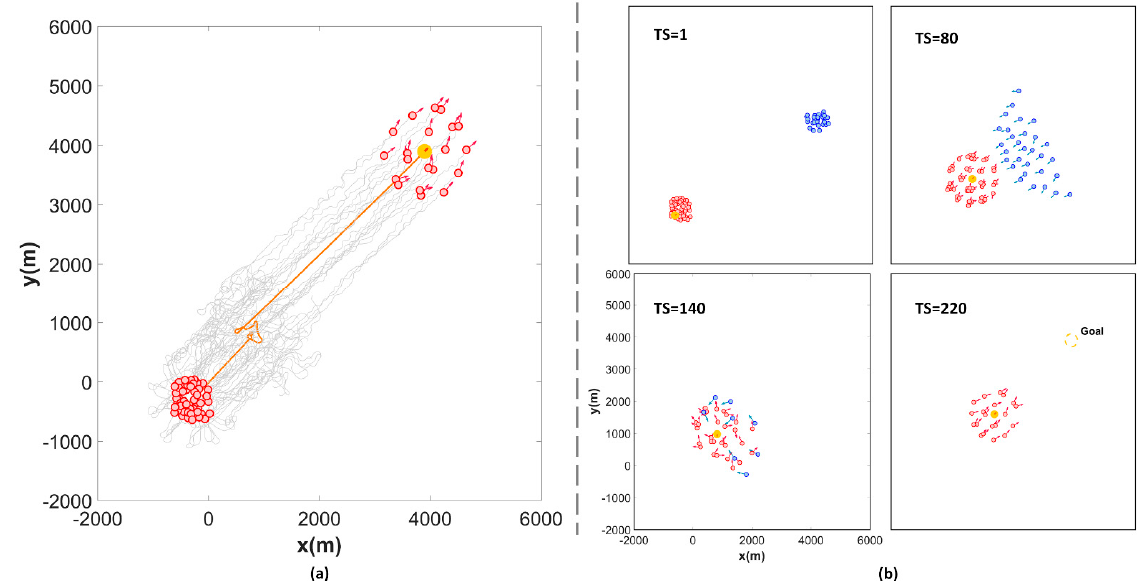
Figure 9. Simulations of 50 defenders escorting the HVU under the attack of 30 aggressive individuals with constraints. ( a ) Trajectories of the escort individuals (light gray lines) and HVU (orange line). ( b ) Snapshots of simulations.